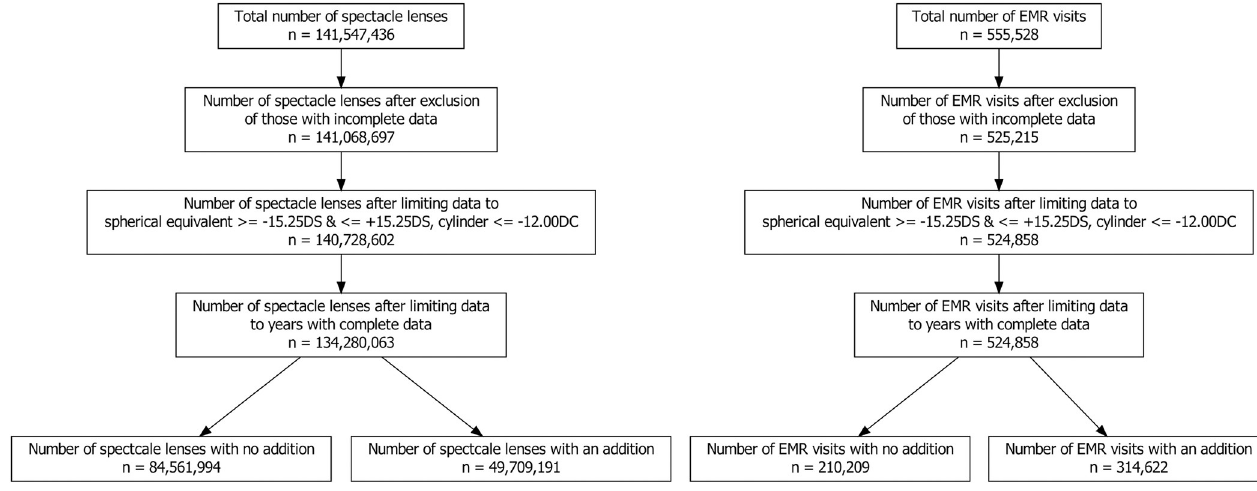
Fig 1. Number of spectacle lenses and EMR visits included in